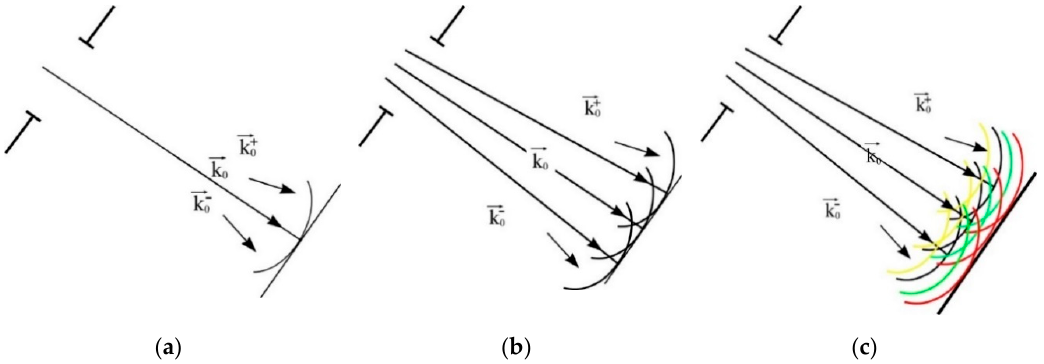
Figure 4. Decomposition into wave vectors (plain fronts) in the case of: ( a ) a point source; ( b ) an Figure4. Decompositionintowavevectors(plainfronts)inthecaseof: ( a )apointsource; ( b )anextended extended source; and ( c ) an extended polychromatic source. source; and ( c ) an extended polychromatic source.